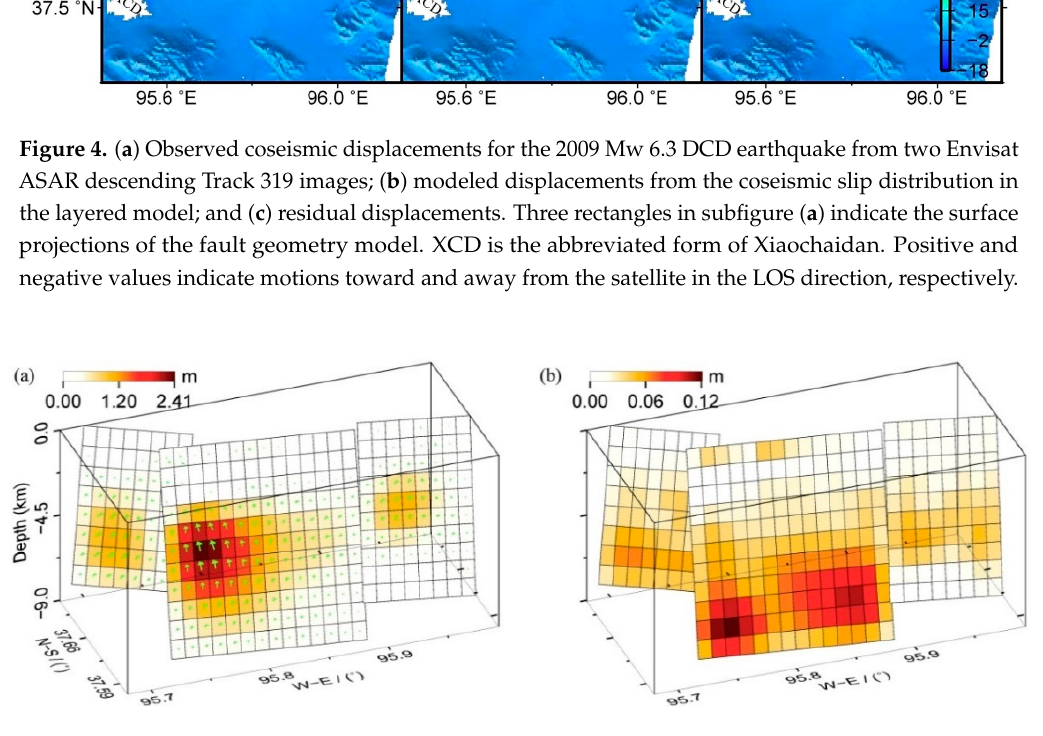
Figure 5. ( a ) Coseismic slip distribution of the 2009 DCD earthquake in the layered model; and ( b ) slip uncertainties estimated from the Monte Carlo calculation with 100 perturbed datasets. Green arrows in ( a ) indicate the slip direction on the corresponding fault patch.